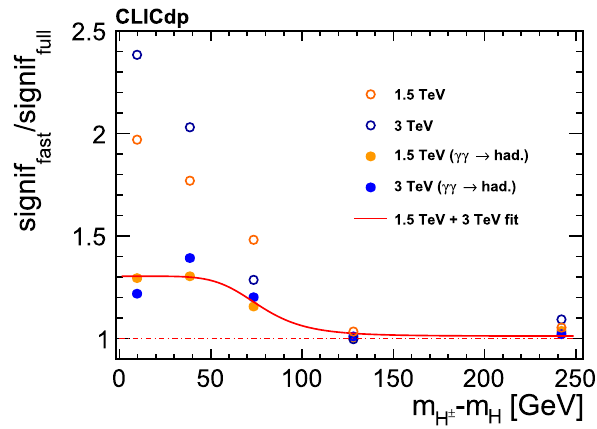
Fig. 6 Ratios of the expected observation significances resulting from fast and full simulation studies. Open circles correspond to Delphes simulation results with no overlaid γγ had. events, while full circles → show the ratios after inclusion of this background, for CLIC running at 1.5TeV (orange) and 3TeV (blue points). The red curve corresponds to the dependence described by Eq. (3) used to correct for the remaining difference between full simulation results and Delphes with overlay at both energy stages. See the text for